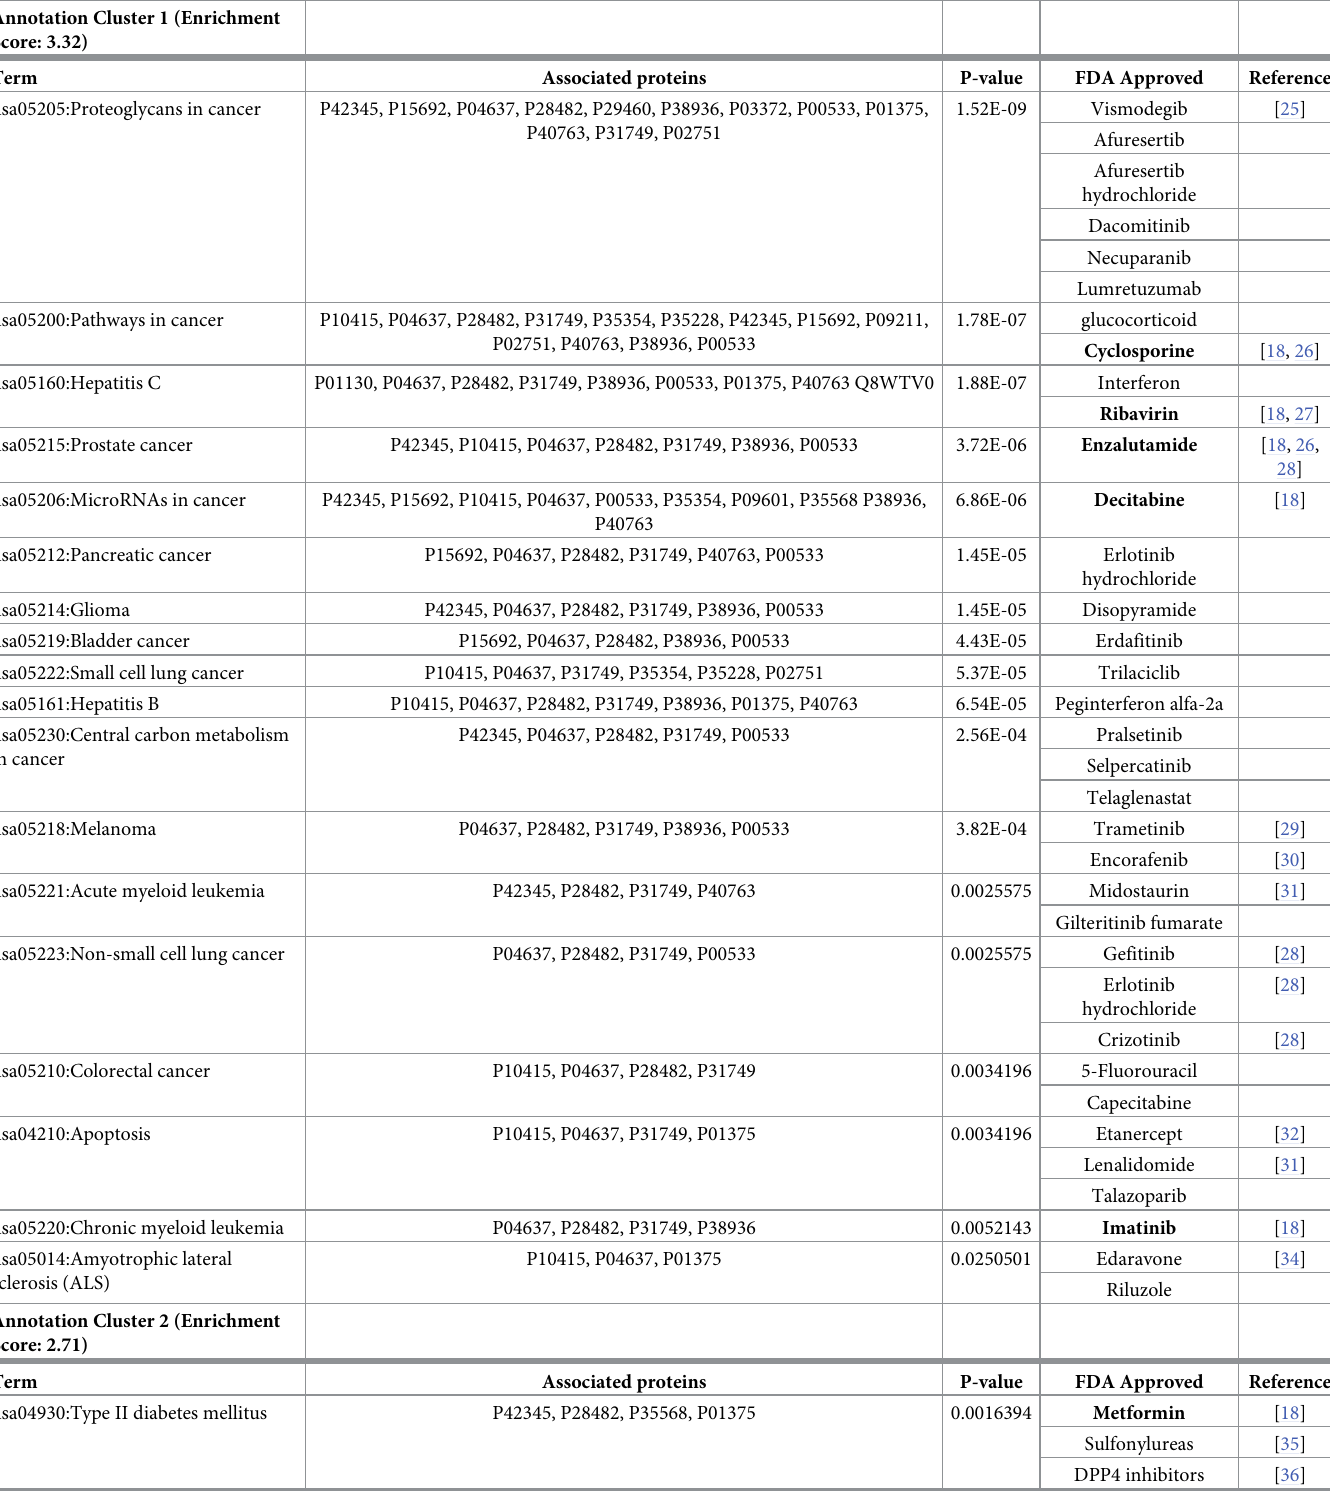
Table 8. Some of the significant disease-pathways associated with COVID-19. (Drugs in Clinical-Drug group are highlighted in bold font). Annotation Cluster 1 (Enrichment Score: